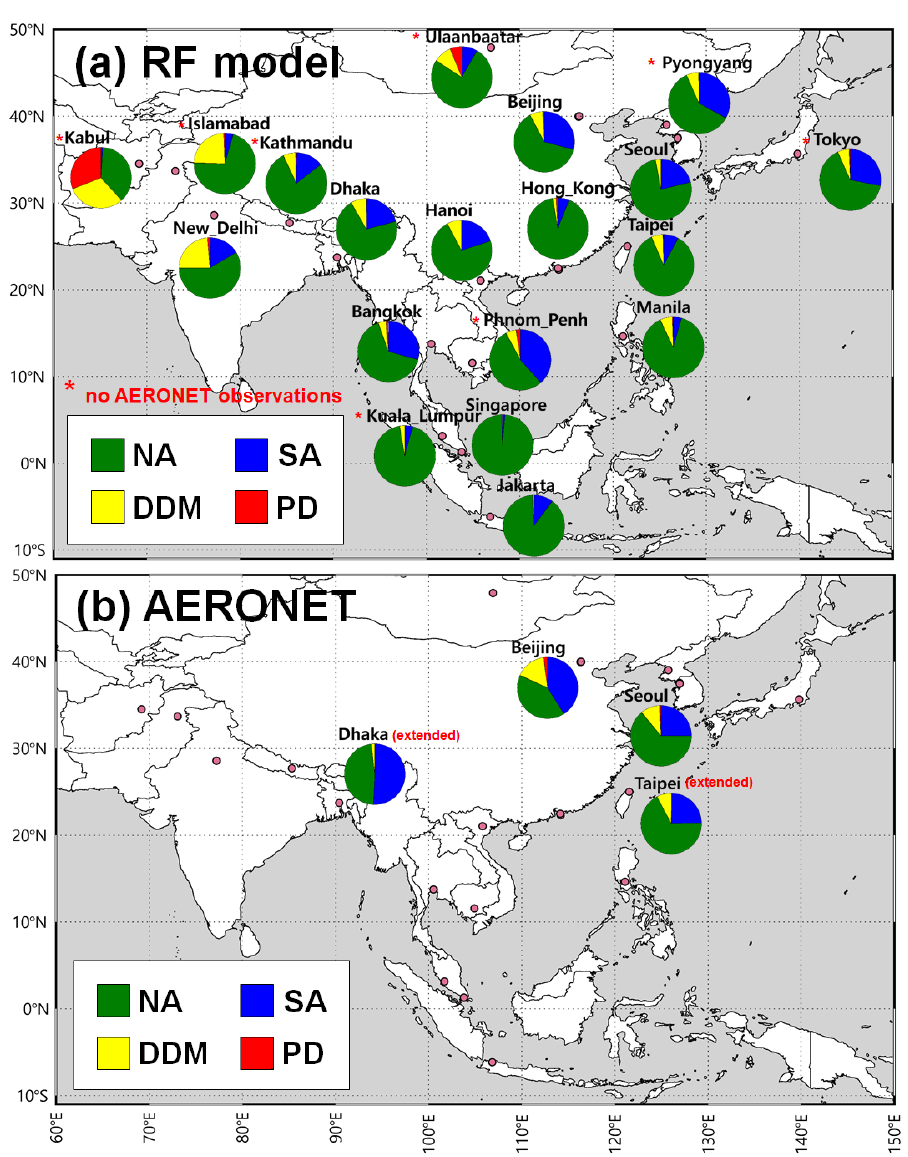
Figure 3. Pie charts showing aerosol-type detection proportions by ( a ) the RF model and ( b ) the AERONET-based model [22]. Abbreviations: NA, non-absorbing; SA, strongly absorbing; DDM, dust dominated mixed; PD, pure dust.